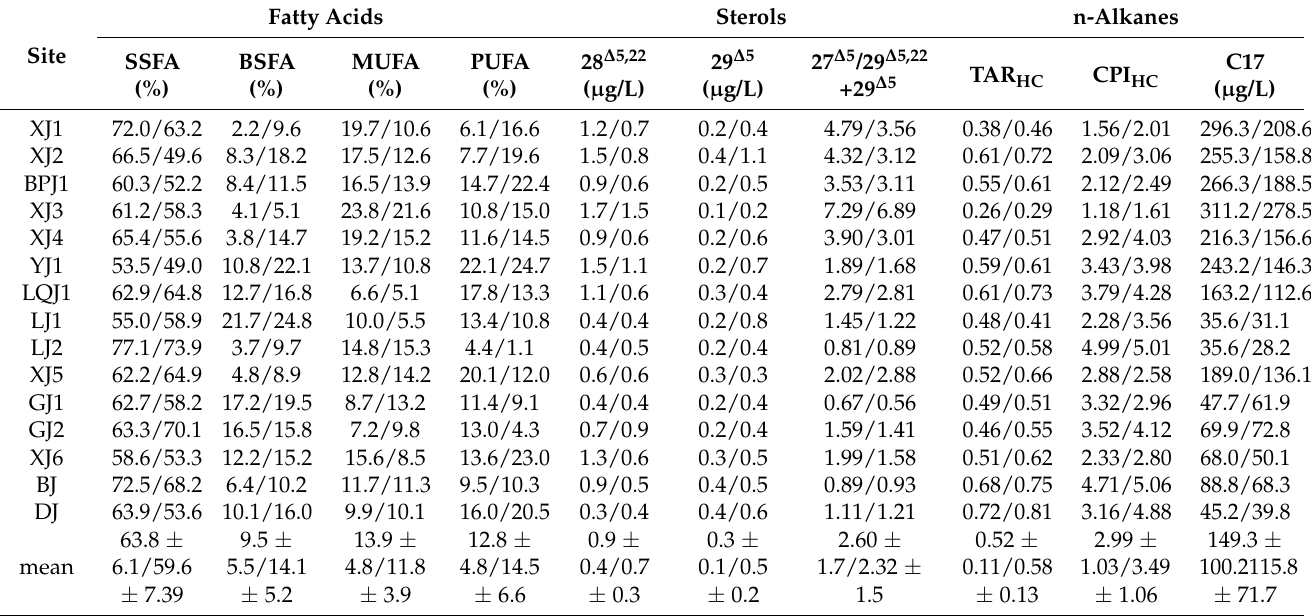
Table 2. Biomarkers at various sites in Pearl River and their relevant